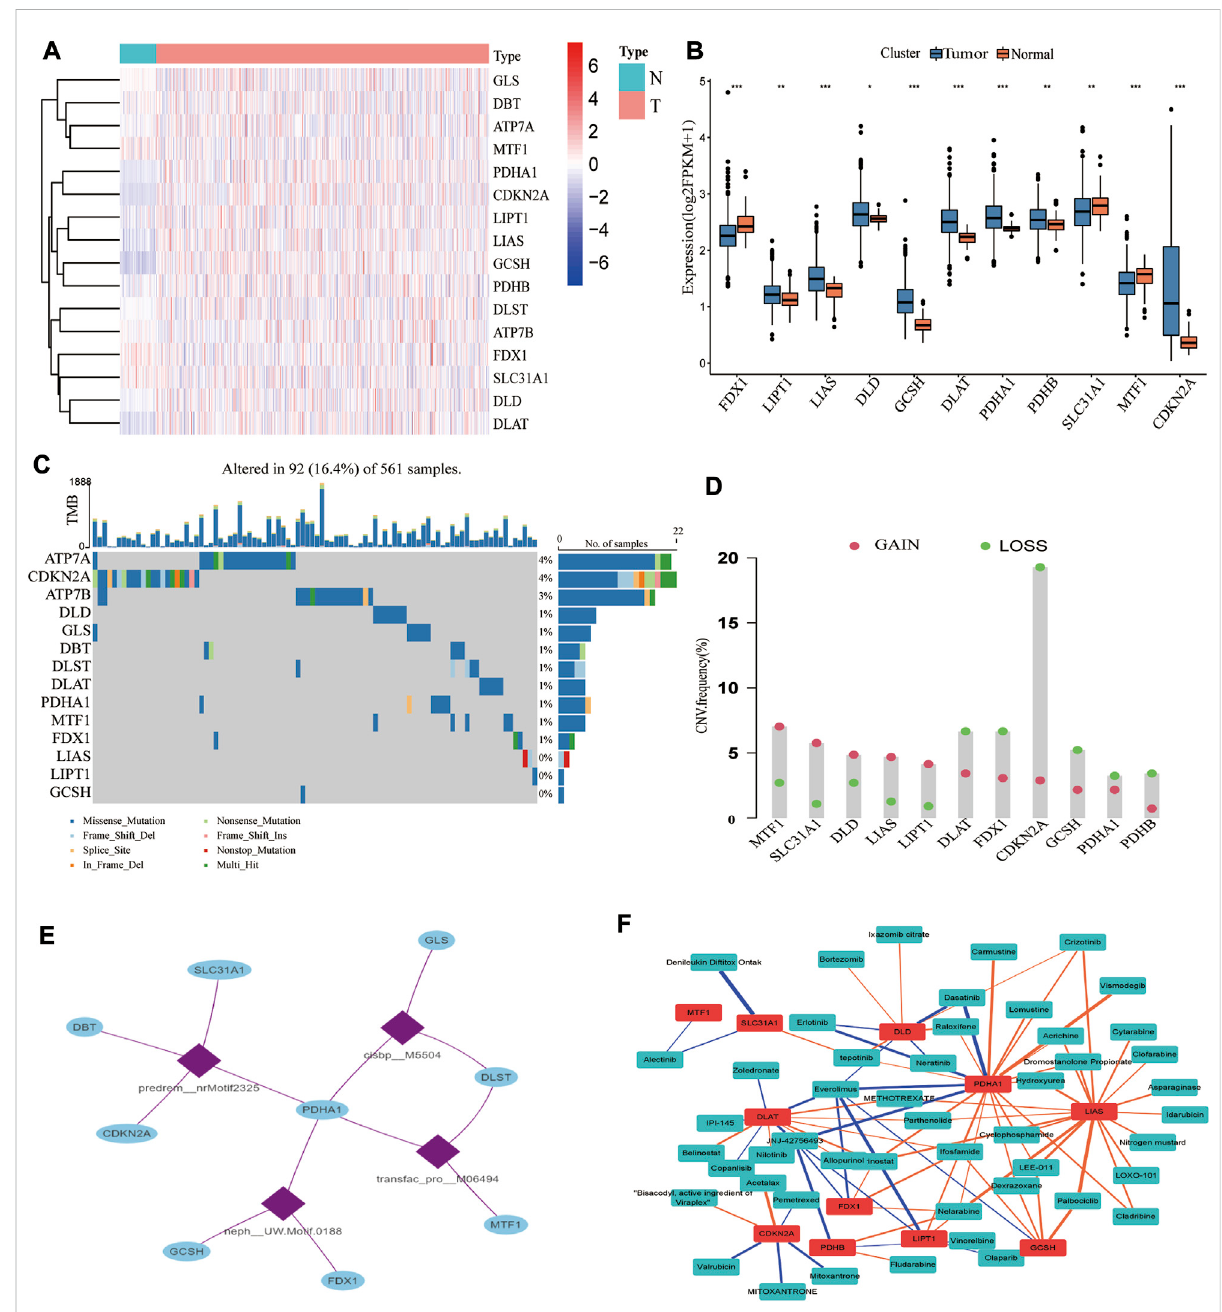
FIGURE 2 Transcriptional and genetic alterations of CRGs, regulatory networks of transcription factors, and sensitive drugs. (A) Heatmap showing the expression pattern of 16 CRGs in LUAD (N: tumor, T: tumor; red represents high expression, blue represents low expression). (B) 11 CRGs were differentiallyexpressedinnormalandtumortissues. (C) SomaticmutationsofCRGs. (D) ThemutationfrequencyofCNVisprevalentinCRGs. (E) The top 4 transcriptionfactor motifs that mostly possibly regulatethe CRGs. (F) Correlation of 11differentially expressedCRGs with sensitive drug Z scores (blue: negative correlation, orange: positive correlation; thickness of the line represents the strength of the